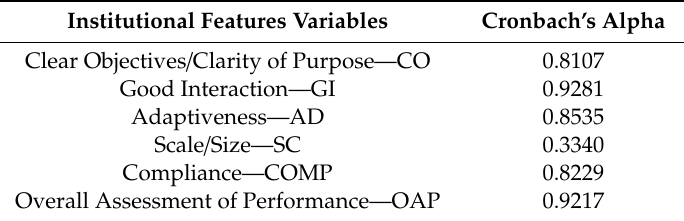
Table 3. Cronbach’s alphas for institutional features variables.